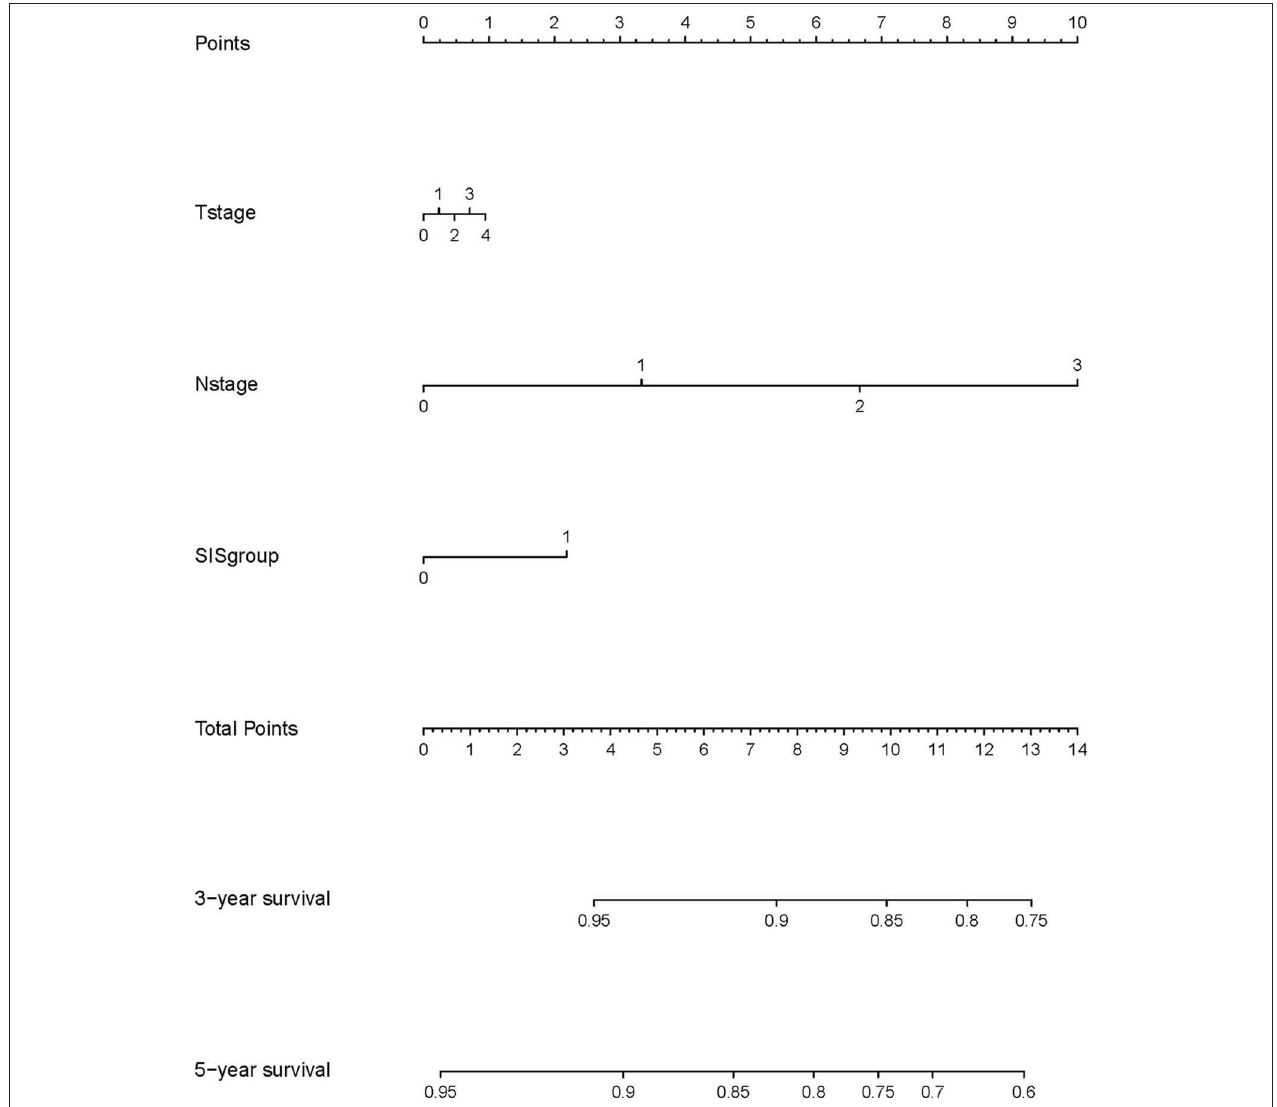
FIGURE 3 | A nomogram predicting the 3- and 5-year distant metastatic free survival of postoperative breast cancer patients. T stage: 0: T0; 1: T1; 2: T2; 3: T3; 4: T4. N stage: 0: N0; 1: N1; 2: N2; 3: N3. SIS group: 0: low SIS group; 1: high SIS